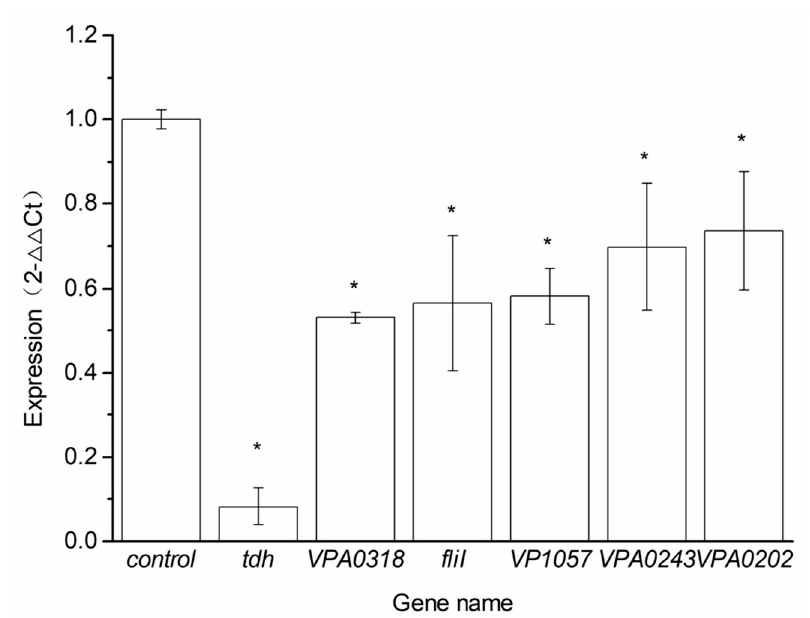
Figure 5. Validation of differentially expressed genes (DEGs) by qRT-PCR. Relative expression of tdh , VPA0318 , fliI , VP1057 , VPA0243 and VPA0202 compared with 16S rRNA of the control normalized to one. The bar results are expressed as means ± SD from three independent replicates. * shows significant differences ( p < 0.05).